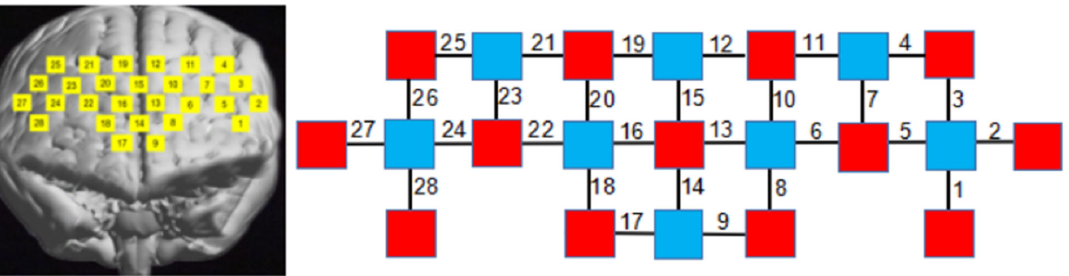
Figure 4. Configuration of the measurement channels in the prefrontal cortex areas. The yellow numbers on the left represent the corresponding detection positions of the photopolar cap in the prefrontal cortical area; the red numbers on the right indicate the emitter (light source); the blue numbers indicate the detector (probe); and the black numbers indicate the established channels.